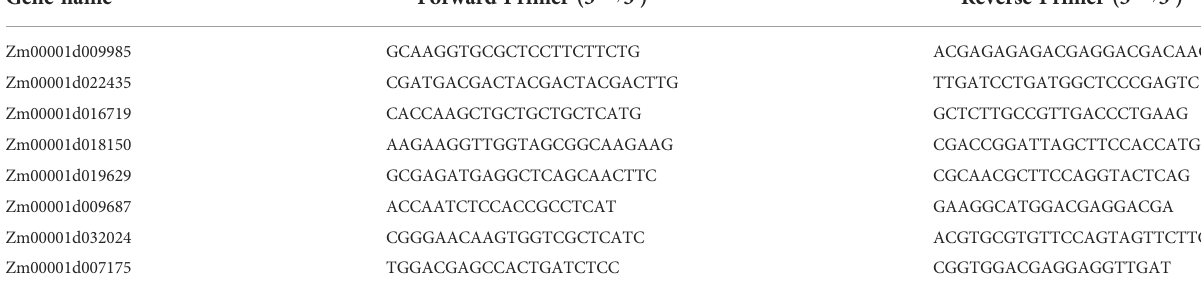
TABLE 1 Primer design